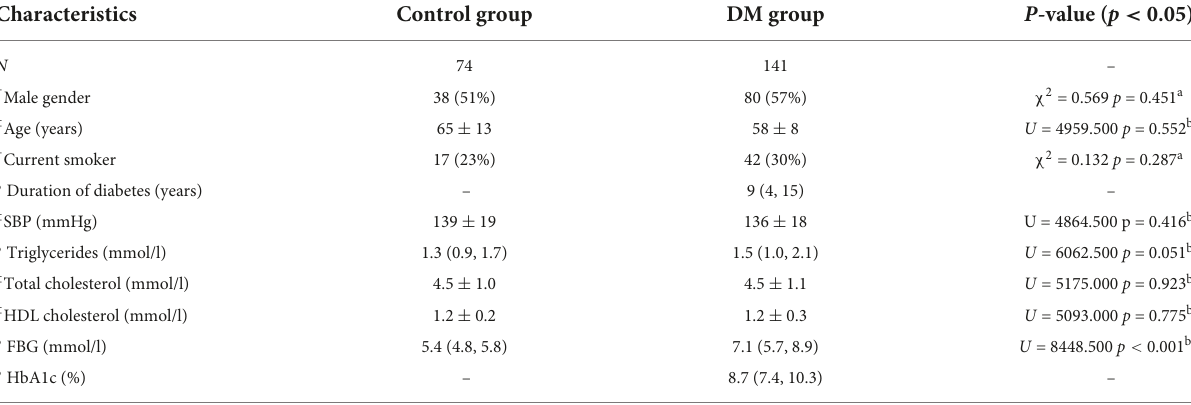
TABLE 3 Comparisons of the clinical and biochemical characteristics among the DM subgroups. Characteristics